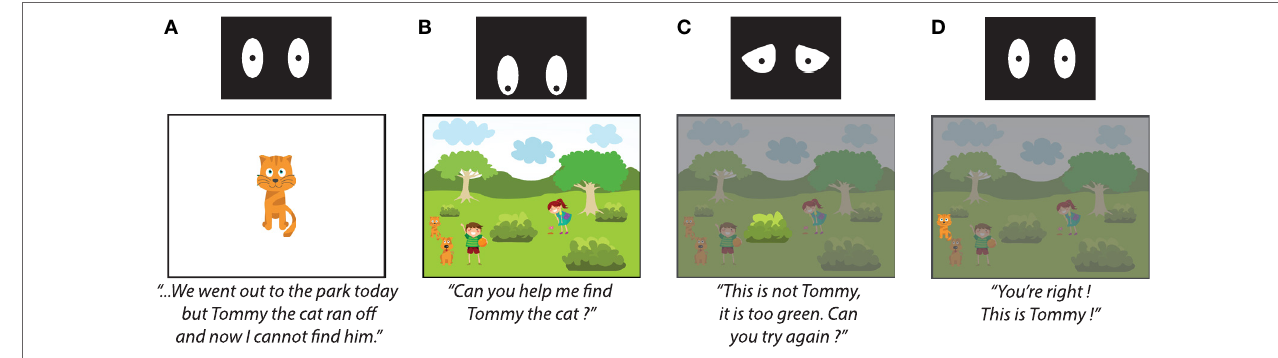
FigUre 2 | The storytelling game. (a) The introduction to a scene, (B) searching for the target animal, (c) selecting a distractor, and (D) selecting the target. Opie changes expression in response to different events in the game. When the child is invited to touch the torso tablet, Opie looks down at that tablet. When the child makes a mistake, Opie adopts sad looking eyes. (c) and (D) show the effect of the overlay on the